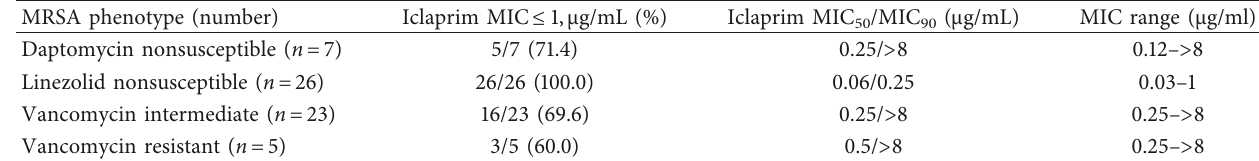
Table 1: Iclaprim in vitro activity against MRSA isolates nonsusceptible to daptomycin, linezolid, or vancomycin. MRSA phenotype